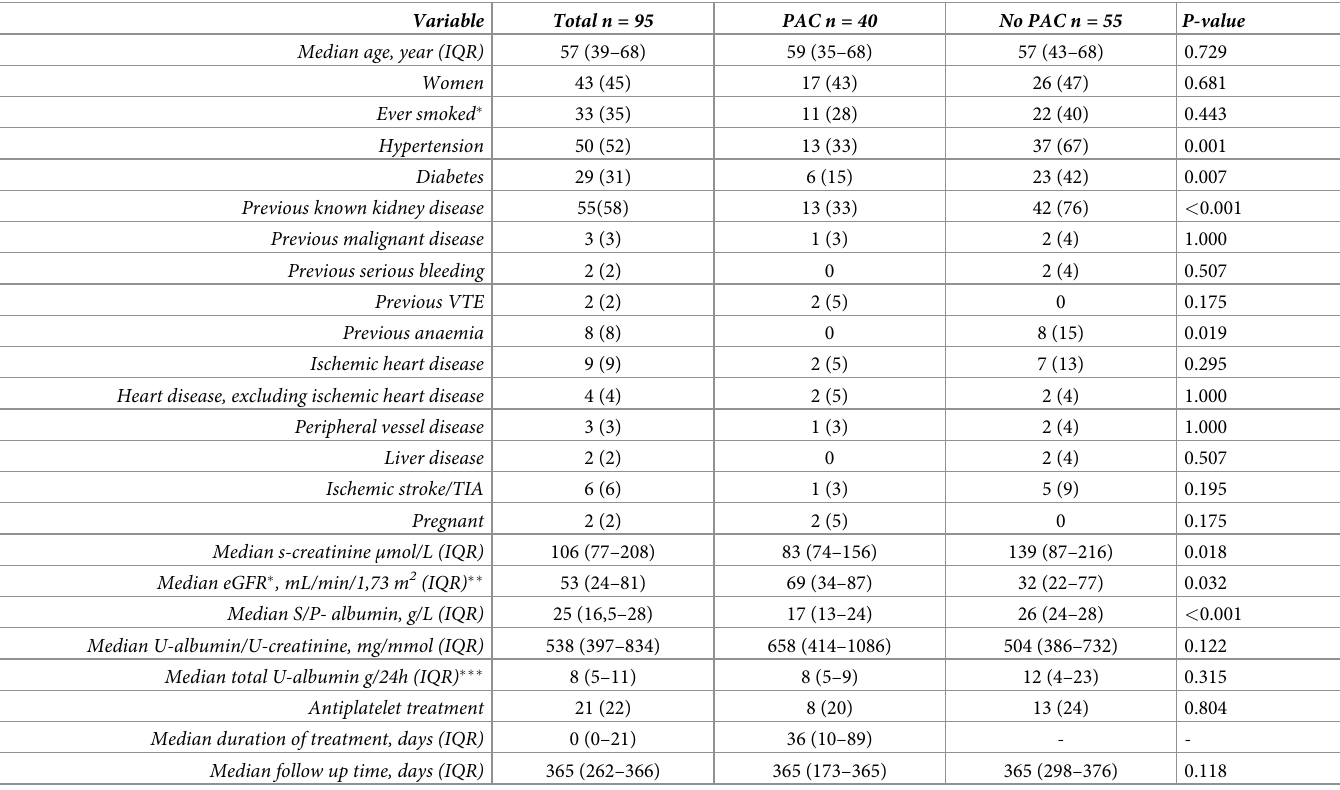
Table 1. Baseline characteristics.